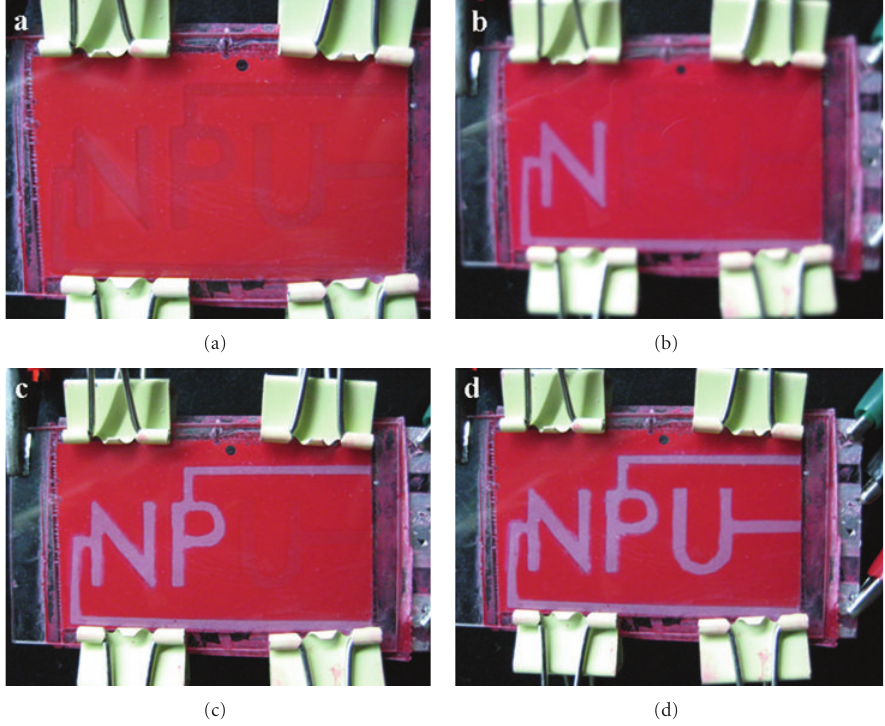
Figure 3: Picture of quasi-dynamic electrophoretic